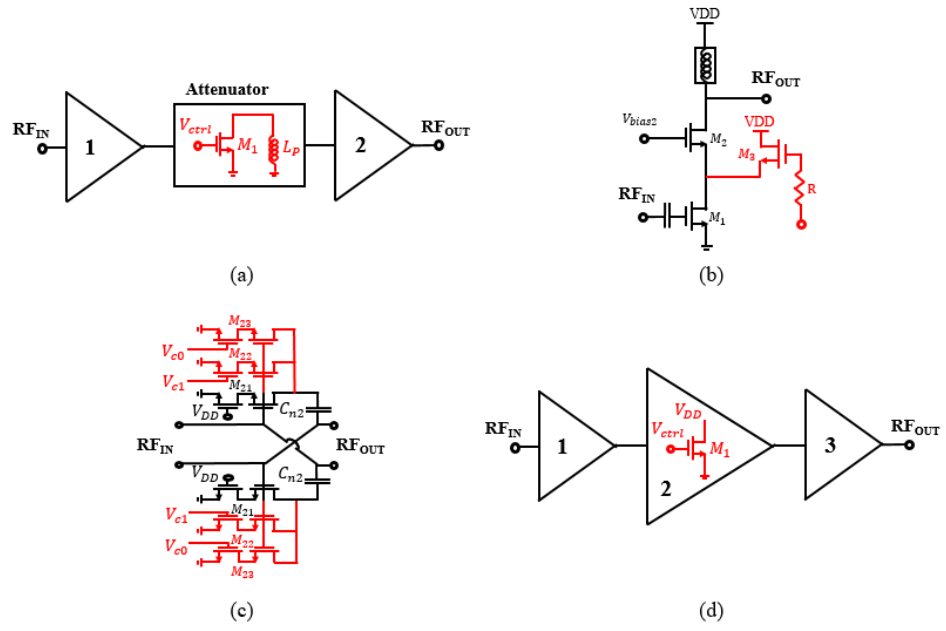
Figure 1. Four topologies of variable-gain amplifiers (VGAs) utilized in millimeter-wave. ( a ) Attenuator control technique, ( b ) current steering technique, ( c ) digital switching technique, and ( d ) bias current control technique.